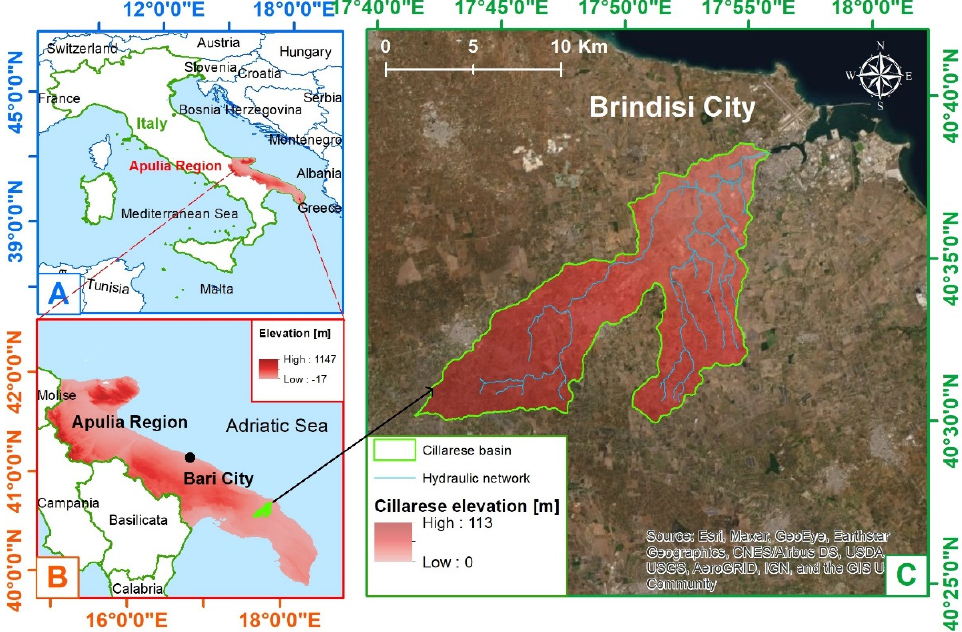
Figure 1. Study area description. ( A , B ) Geographical identification of Cillarese river basin; ( C ) digital elevation model (DEM) of analyzed river basin.